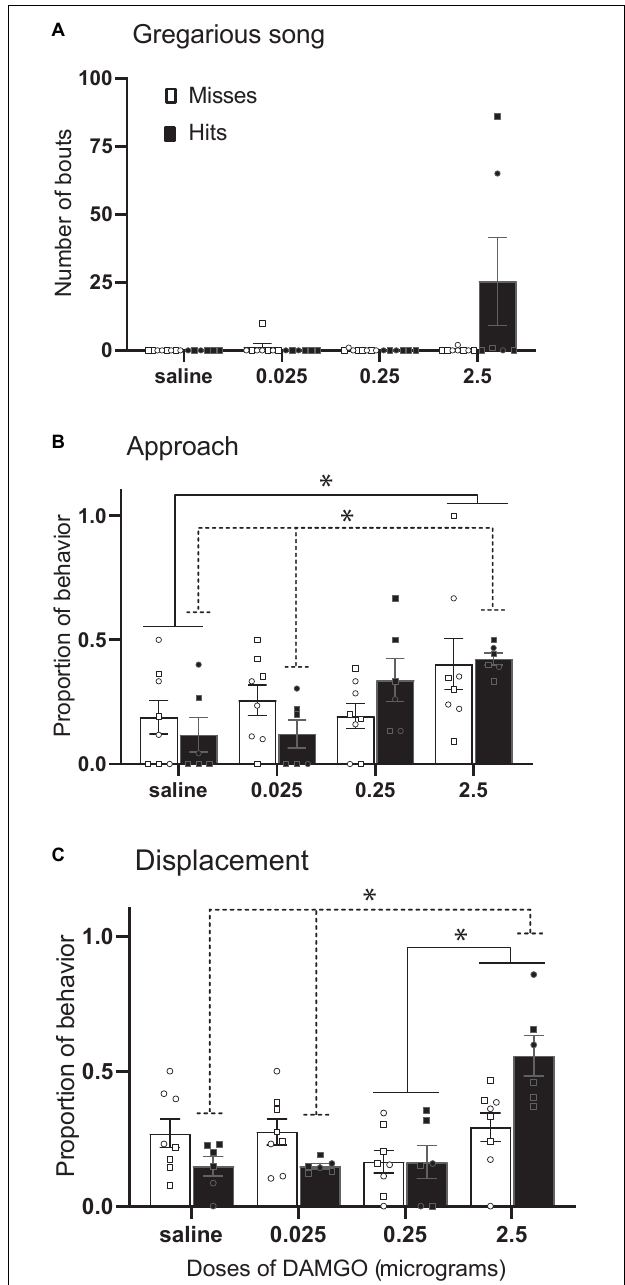
FIGURE 7 | Stimulation of MOR in NAc increases gregarious song, approach, and displacements. Mean + sem (A) number of song bouts, (B) proportion of approach behaviors, and (C) proportion of displacements in male (squares) and female (circles) starlings in which the cannula tip missed the NAc (open bars; n = 8) or hit the NAc (filled bars; n = 6). Lines indicate significant effects (* p < 0.05). Misses were in numerous locations outside the NAc. Figure modified from Maksimoski et al.